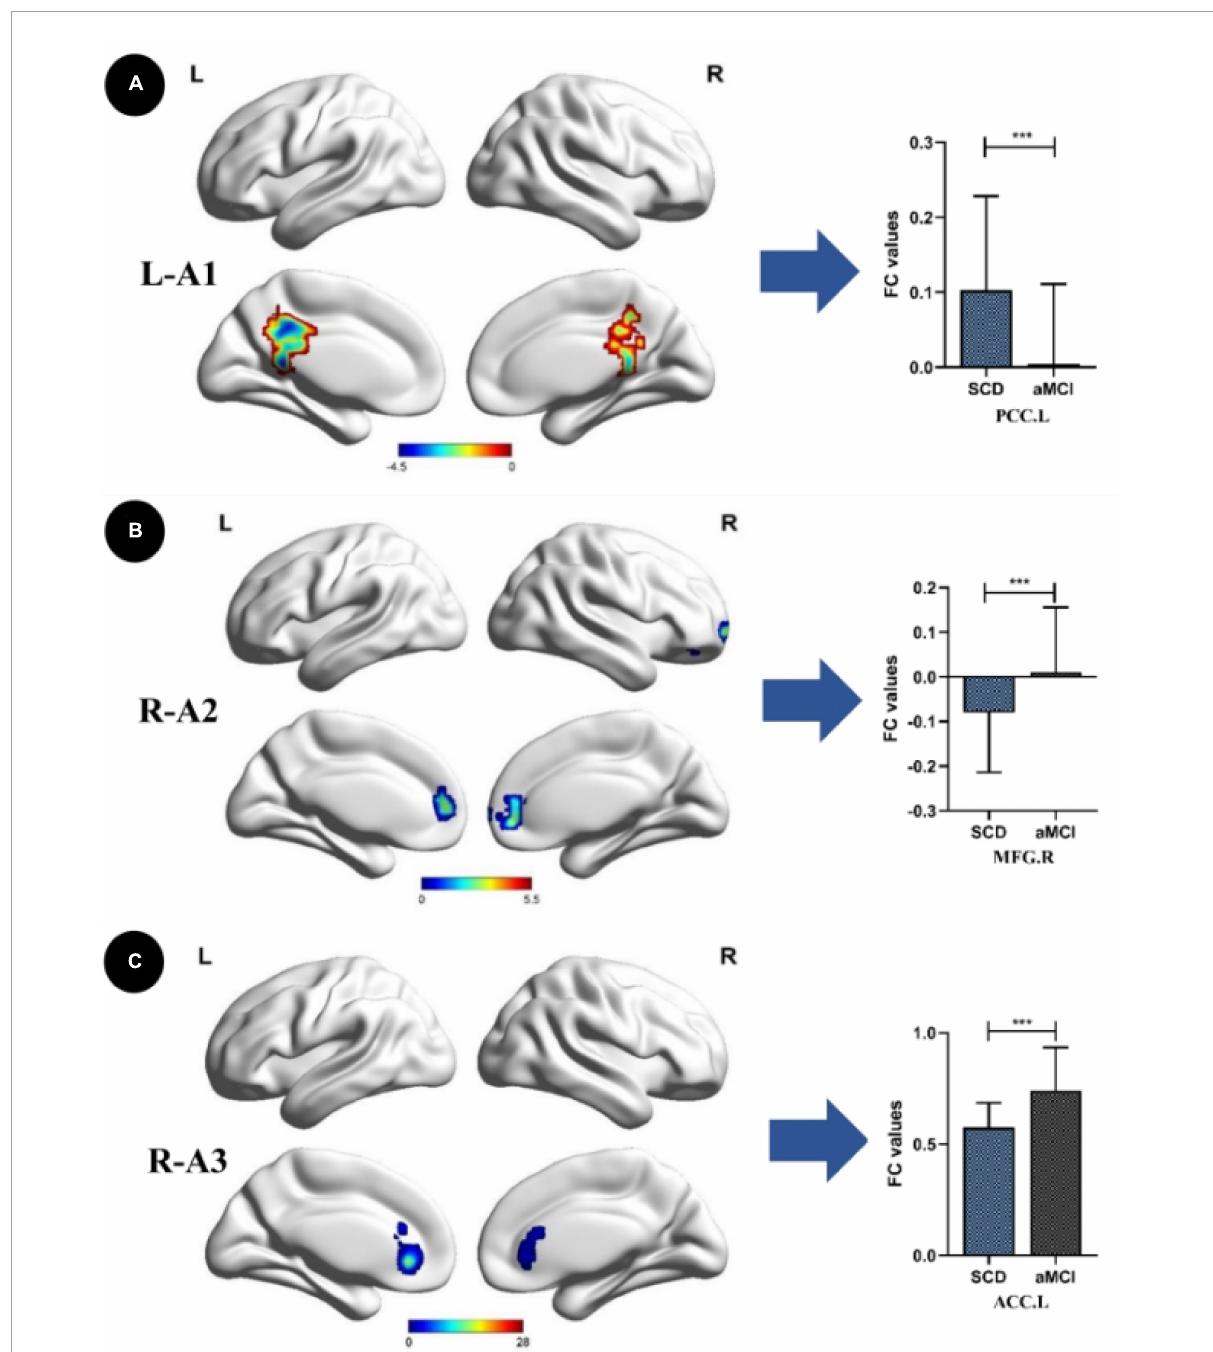
FIGURE4 Anterior cingulate cortex subregions functional connectivity in patients with amnestic mild cognitive impairment (aMCI) compared to subjective cognitive decline (SCD). (A) Functional connectivity (FC) of left caudal anterior cingulate cortex subregion (L-A1) between SCD and aMCl patients. A bar chart indicating the quantitative comparison of FC between these regions. (B) FC of right dorsal anterior cingulate cortex subregion (R-A2) between SCD and aMCI patients. A bar chart indicating the quantitative comparison of FC between these regions. (C) FC of right subgenual anterior cingulate cortex subregion (R-A3) between SCD and aMCI patients. A bar chart indicating the quantitative comparison of FC between these regions. Only the subnetworks that show between-group differences are shown here. All results are displayed after adjusting for age, sex, and education. A threshold of p < 0.05 was applied, with a TFCE-FWE correction with cluster size > 200 mm 3 . FC, functional connectivity; SCD, subjective cognitive decline; aMCI, amnestic mild cognitive impairment; PCC.L, left posterior cingulate; MFG.R, right middle frontal gyrus; ACC.L, left anterior cingulate. *** p <